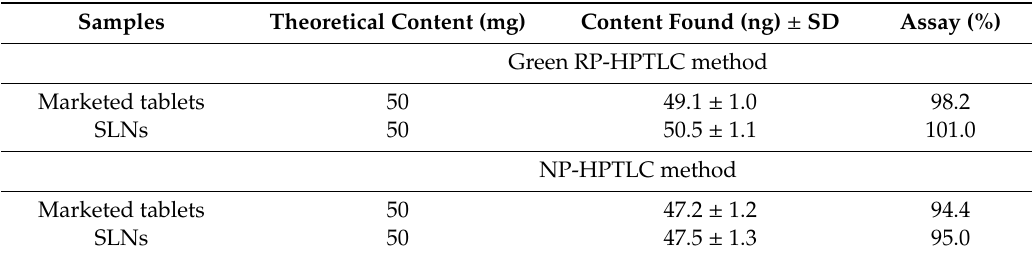
Figure 6. HPTLC chromatogram of DLFX in in-house developed SLNs by NP-HPTLC method. Table 6. Assay of DLFX in marketed tablets and SLNs formulation by the green RP-HPTLC and NP-HPTLC methods ( n =3).